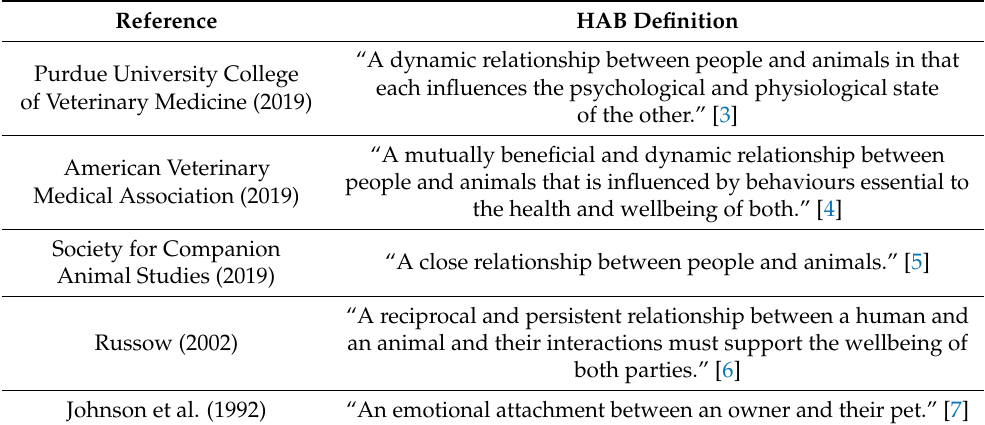
Table 1. Previously published definitions for the human–animal bond